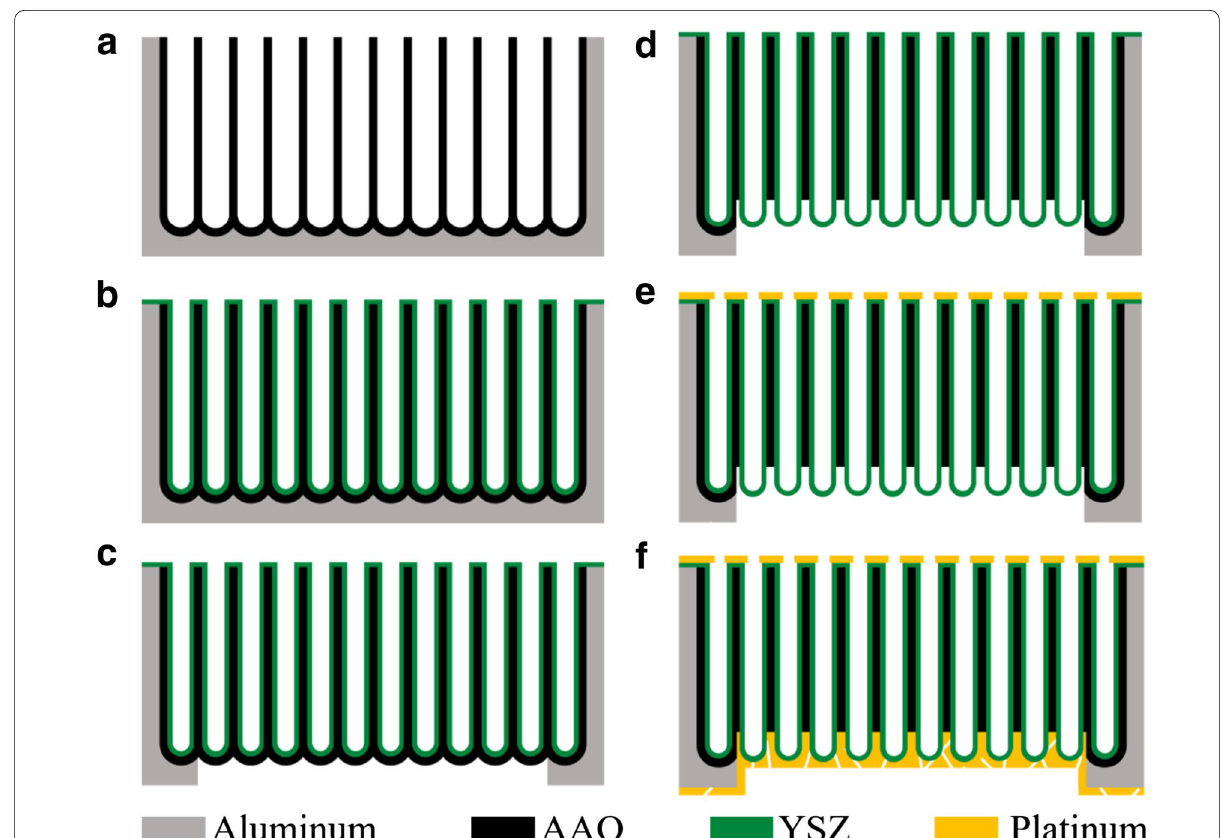
Fig. 4 Fabrication steps for the YSZ-NT array-based MEA. a Preparation of AAO templates. b Deposit the YSZ thin films into the alumina membrane by ALD. c Remove the back-side Al by wet chemical etching. d Partially etching the alumina membrane in order to expose the tube ends. e Sputter porous Pt electrodes onto the top side membrane. f Sputter another porous Pt electrodes on the bottom side